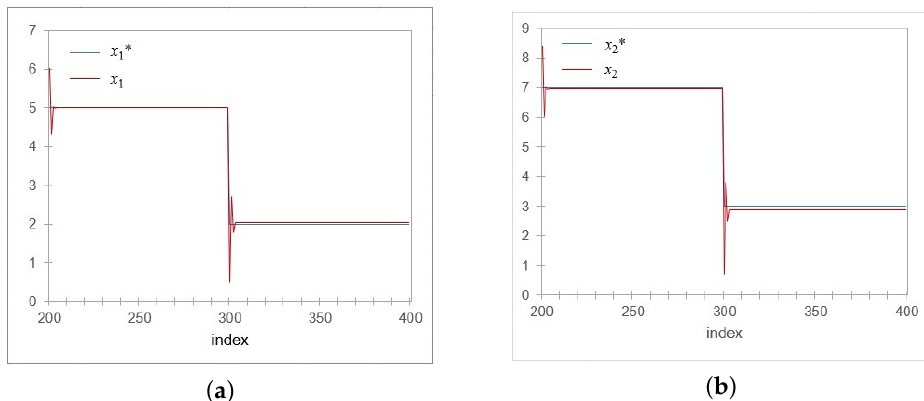
Figure 2. The control results in the absence of interference, when the task control is a stepwise impact for variables: ( a ) x 1 ; ( b ) x 2 .